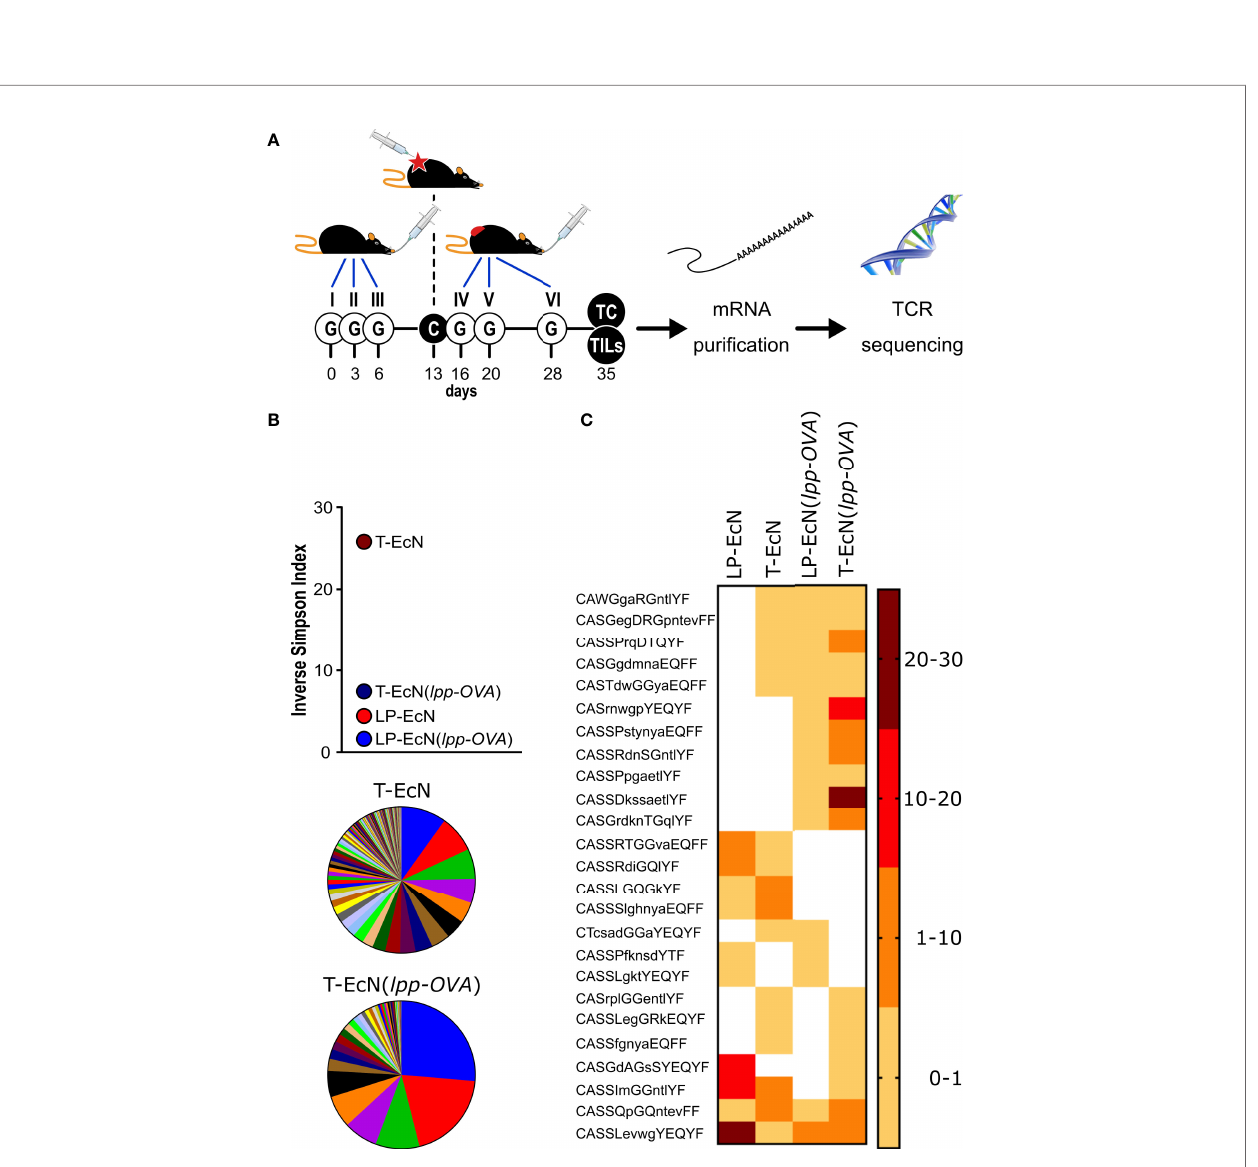
FIGURE 4 | Analysis of TCR sequencing of CD8 + T cells from lamina propria and tumors. (A) Schematic representation of the experimental protocol. Mice (5 animals/group) were treated as depicted and at the end of the experiment CD8 + T cells were collected from the lamina propria and tumor of each animal. After RNA extraction, the TCR b subunit was subjected to sequence analysis. (B) Analysis of TCR b subunit diversity using the Inverse Simpson Index. The analysis was carried out after pooling the TCR sequences of each group (5 mice/group). The pie charts illustrate the different clonotypes identi fi ed in the tumors from EcN-treated mice (T-EcN) and from EcN( lpp-OVA )-treated mice (T-EcN( lpp-OVA ). (C) Heat map showing the sharing of identical CDR3 amino acid sequences among different experimental groups. Color legend indicates the frequency of the clonotypes measured as relative sequence count. T: tumor; LP: lamina propria .